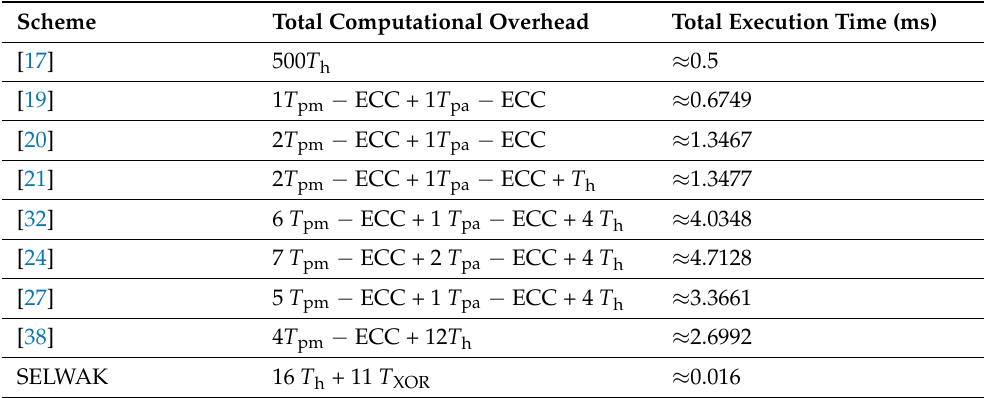
Table 2. Computation Cost